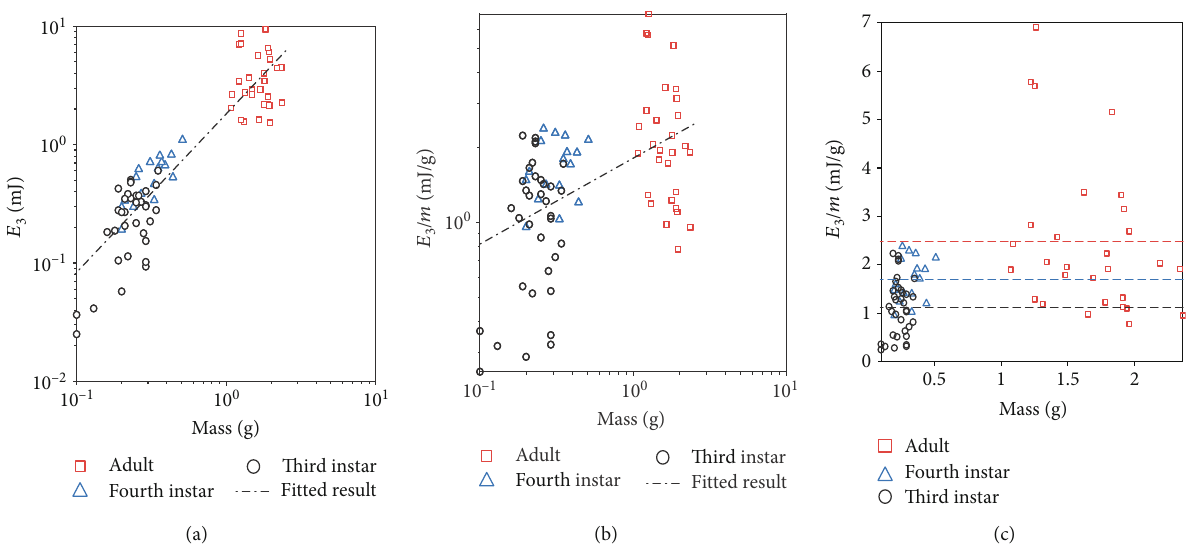
Figure 4: (a) The allometric relationship between jump energy and body mass of all tested third instar, fourth instar, and adult locust jumps. All tested jumps were included in the regression: E 3 = 1 : 8018 m 1 : 342±0 : 16 ( R 2 = 0 : 8288 ). (b) The allometric relationship between mass-speci fi c work (the ratio of jump energy divided by body mass) and body mass of all tested third instar, fourth instar, and adult locusts ’ jumps. All tested jumps were included in the regression: E 3 = 1 : 8018 m 0 : 342±0 : 136 ( R 2 = 0 : 2388 ). (c) The allometric relationship between mass-speci fi c work and body mass of all tested third instar, fourth instar, and adult locust jumps. The straight red, blue, and black lines are the average ratio of jumping energy divided by body mass of all tested third instar, fourth instar, and adult locusts